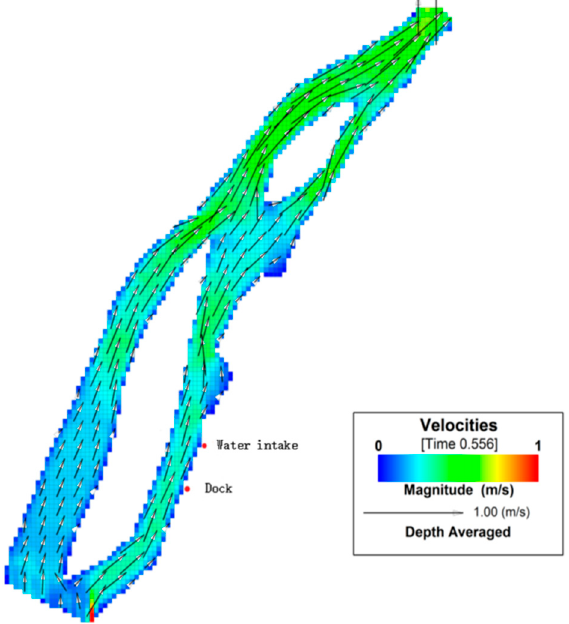
Figure 3. The flow field distribution map of the calculation area at the drop rush time .